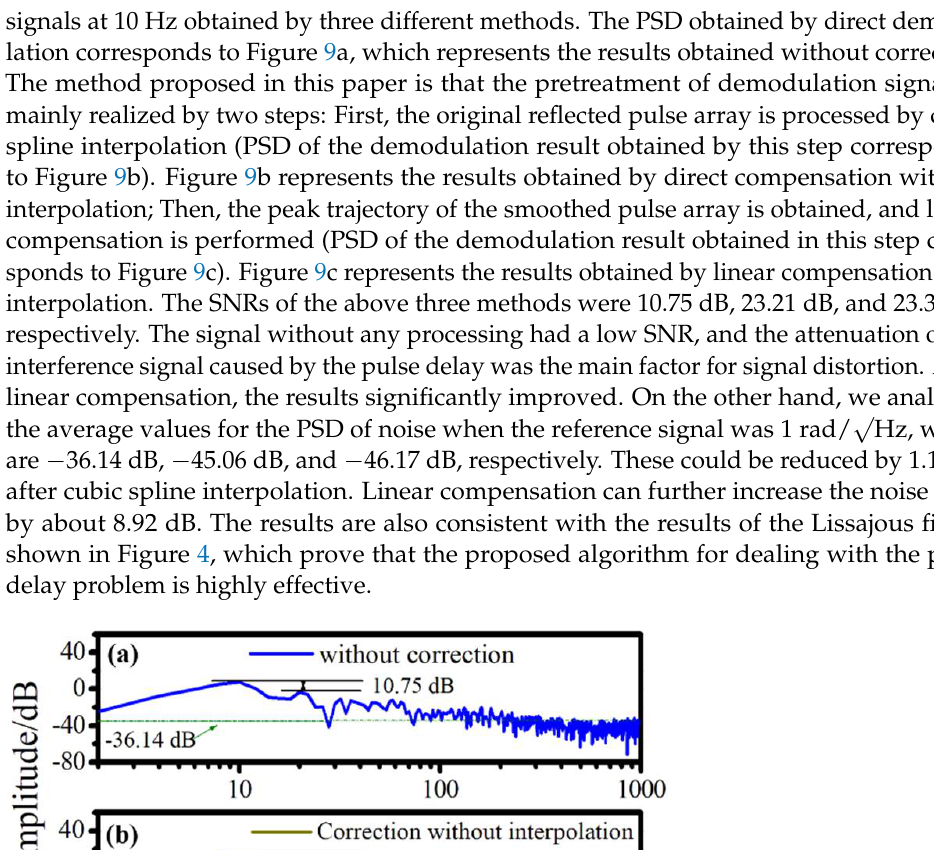
Table 1. Results of PSD for original and correction at different